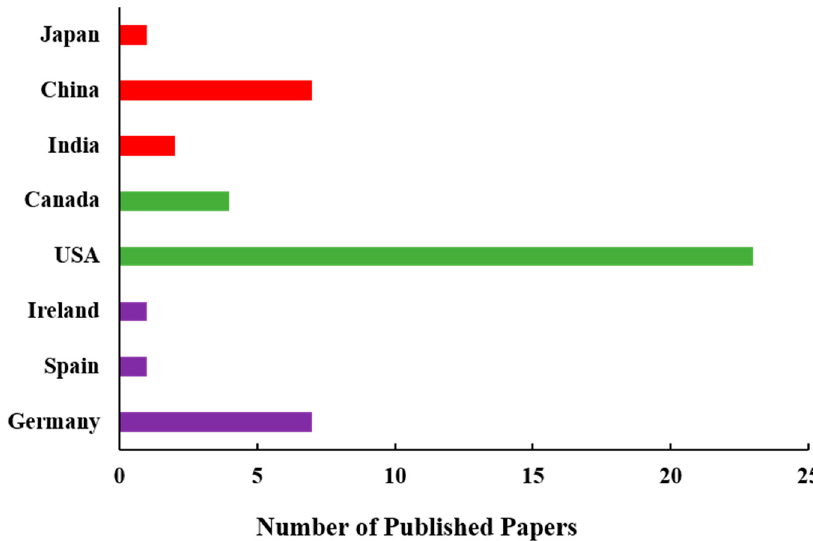
Figure 5. Bar graphs represent the country-wise spaceborne SIF studies published until 2019. Color of the bar represents different continents (Red = Asia, Green = North America, Violet = Europe). Note: the first author and/or corresponding author (if different) affiliations were used as the main criterion on defining the country of origin of the paper.